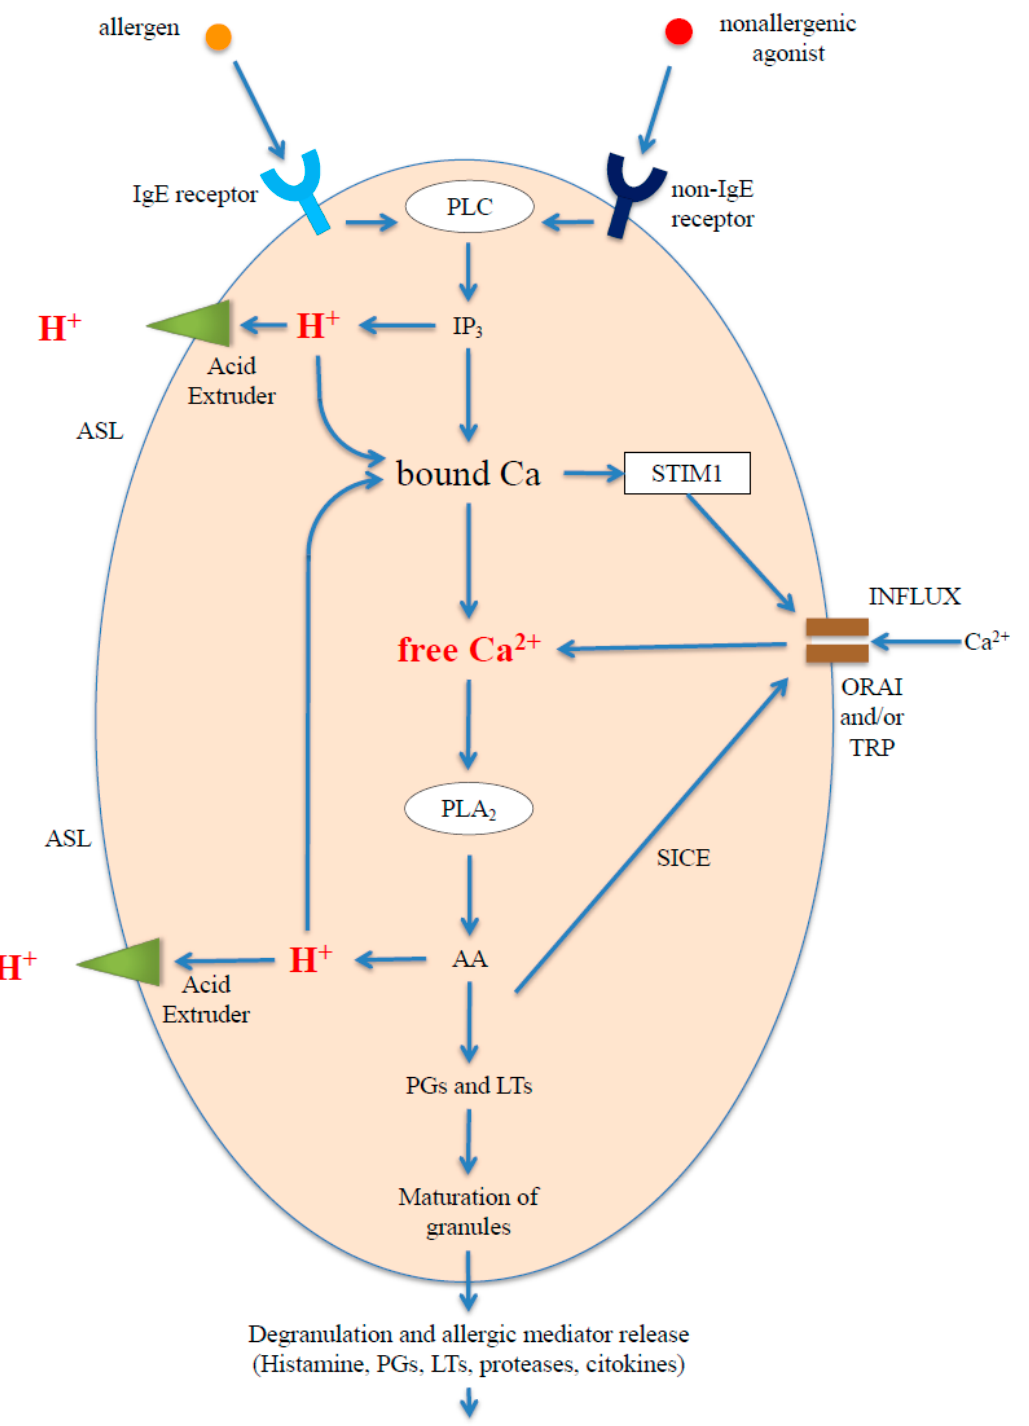
Figure 1. Basic biochemical mechanism of allergic-type response; PLC — Phospholipase C ; PLA 2 — Phospholipase A 2 ; AA — Arachidonic Acid ; SICE — Store-Independent Calcium Entry ; PGs — Prostaglandins ; LTs — Leukotrienes ; ASL — Airway Surface Liquid